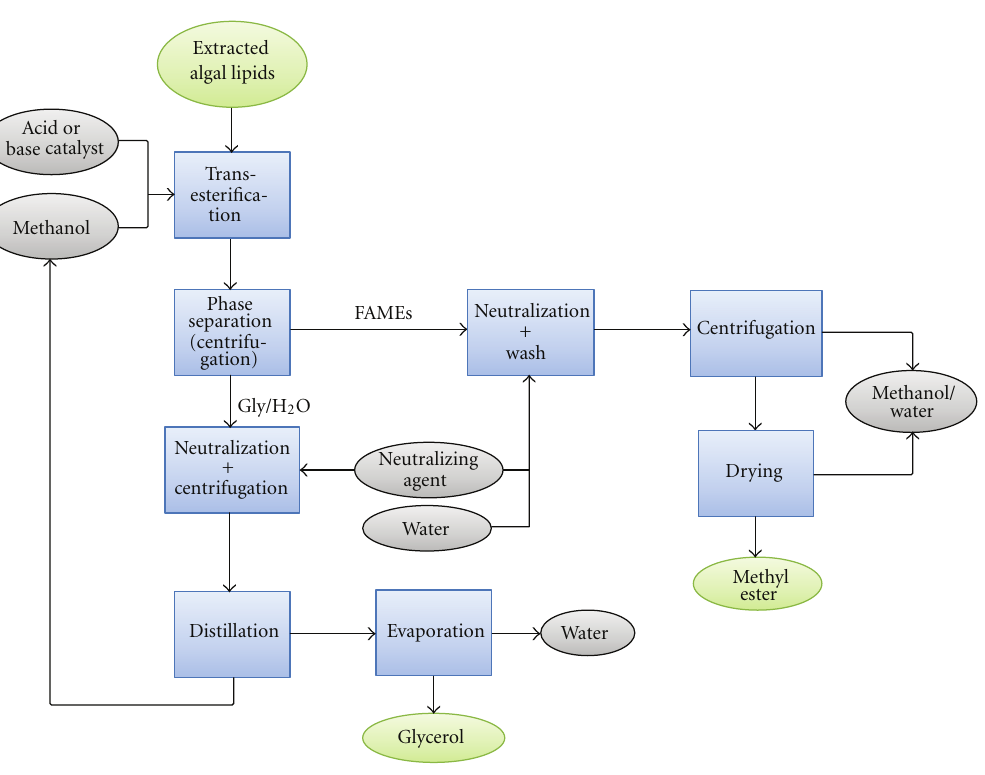
Figure 5: Scheme of conventional biodiesel processing [52–54].